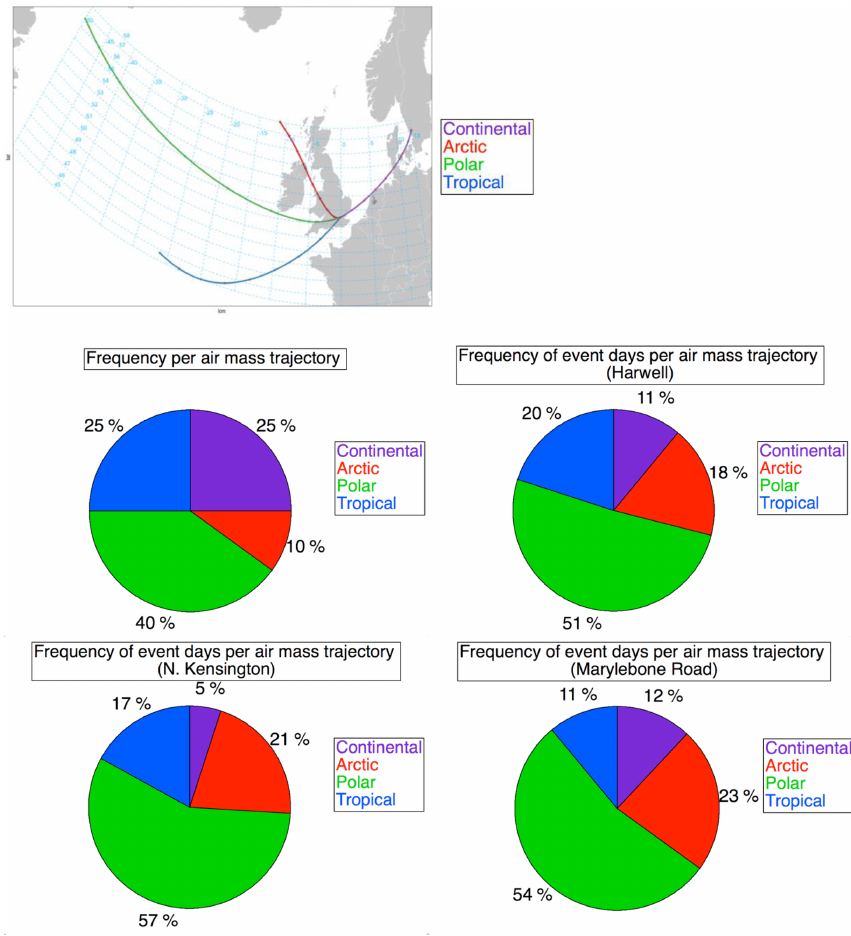
Figure 5. Map and frequency of incoming air mass origin – average and for NPF events per